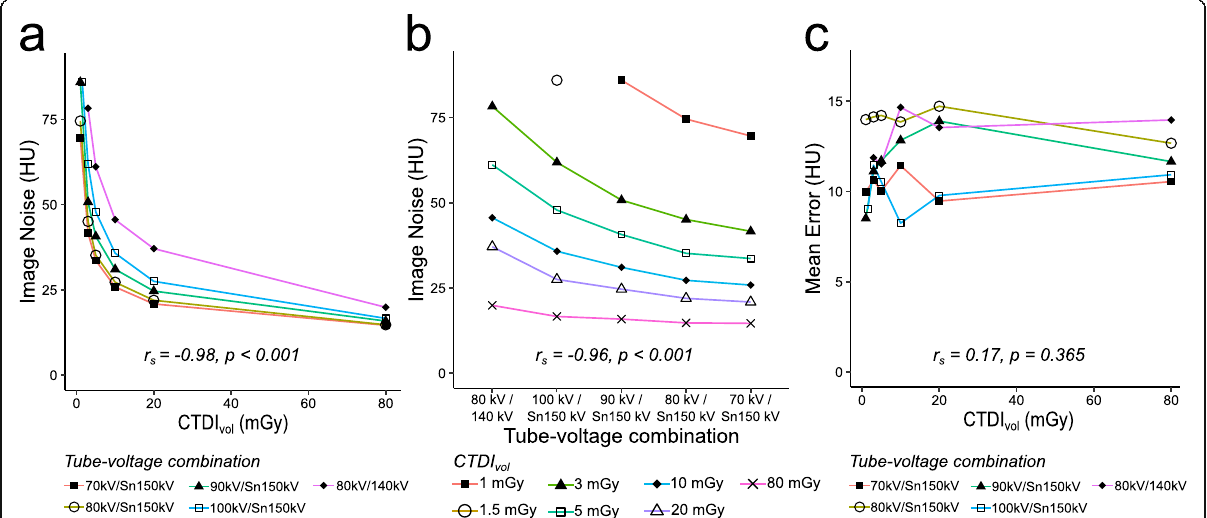
Fig. 2 Increased spectral separation and dose decrease noise in virtual non-calcium images. Image noise decreases continuously as dose ( a ) and spectral separation ( b ) is increased. Image noise is defined as the standard deviation in the bone on virtual non-calcium images. Tube-voltage combinations are sorted with increasing spectral separation from left to right in ( b ). CTDI vol could not be set below 1.5mGy at 100kV/Sn150 kV and 3mGy at 80kV/140kV. c No correlation can be seen between increased dose and accuracy, defined as mean error between the fluid within bone against the same fluid outside bone.